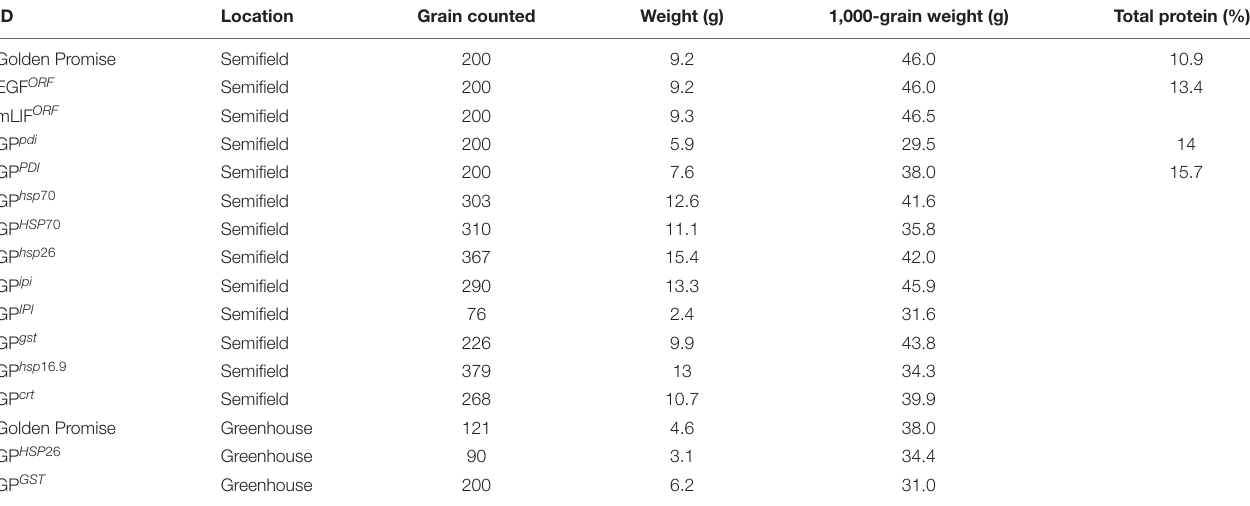
TABLE 2 | One thousand-grain weight of all transformants and